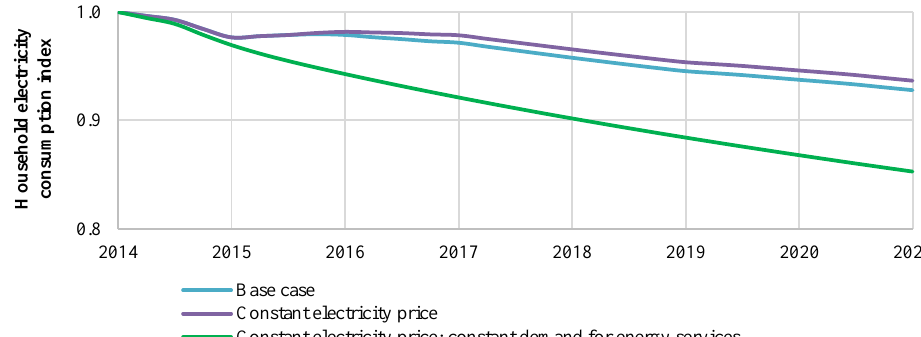
Fig. 14. Total household electricity consumption index for the base case (the reference), the case with a constant electricity price, and the case with a constant efficiency of technologies and no change of behavior (no reduction of use of light bulbs and electric appliances, no replacement of electric water heaters with alternatives) and constant demand for energy services (lighting, use of electric appliances, heating and cooling); (the initial consumption: 1887